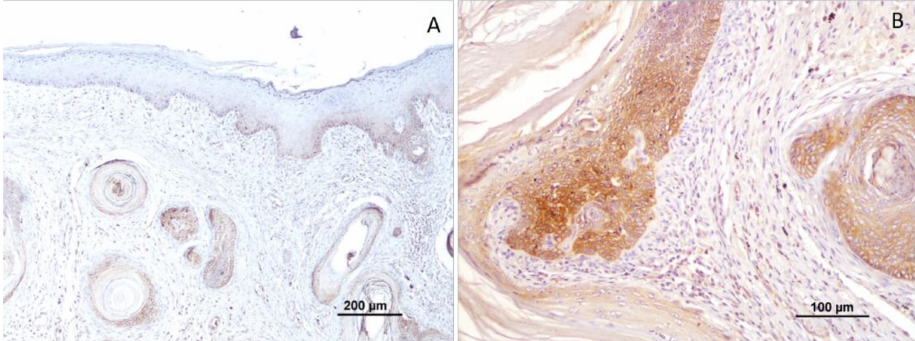
Figure 2. CTEN immunoreactivity in well-differentiated tumors (grade I). ( A ) Negative immunoreactiv- ity. Note the non-tumoral epidermis with labeling similar to tumoral cells. ( B ) Positive immunoreactivity. In total, 55.6% (25 squamous cell carcinomas) revealed negative CTEN expression and 44.4% (20 cases) were positive for this marker. Considering the well-differentiated tumors, only 5% (1 case) showed positive CTEN expression, while 93.3% (14 cases) accounted for negative CTEN expression. Moderately differentiated squamous cell carcinomas ( n = 17) revealed negative CTEN expression in 11 cases (64.7%) and a positive reaction in 6 cases (35.3%) (Figure 3). The higher tumor grading (poorly differentiated tumors) showed CTEN immunoreactivity in all cases ( n = 13; 100%); Figure